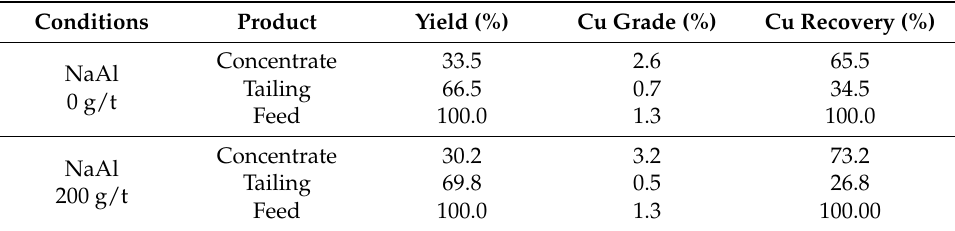
Table 2. Effect of NaAl on the flotation separation of real ore.